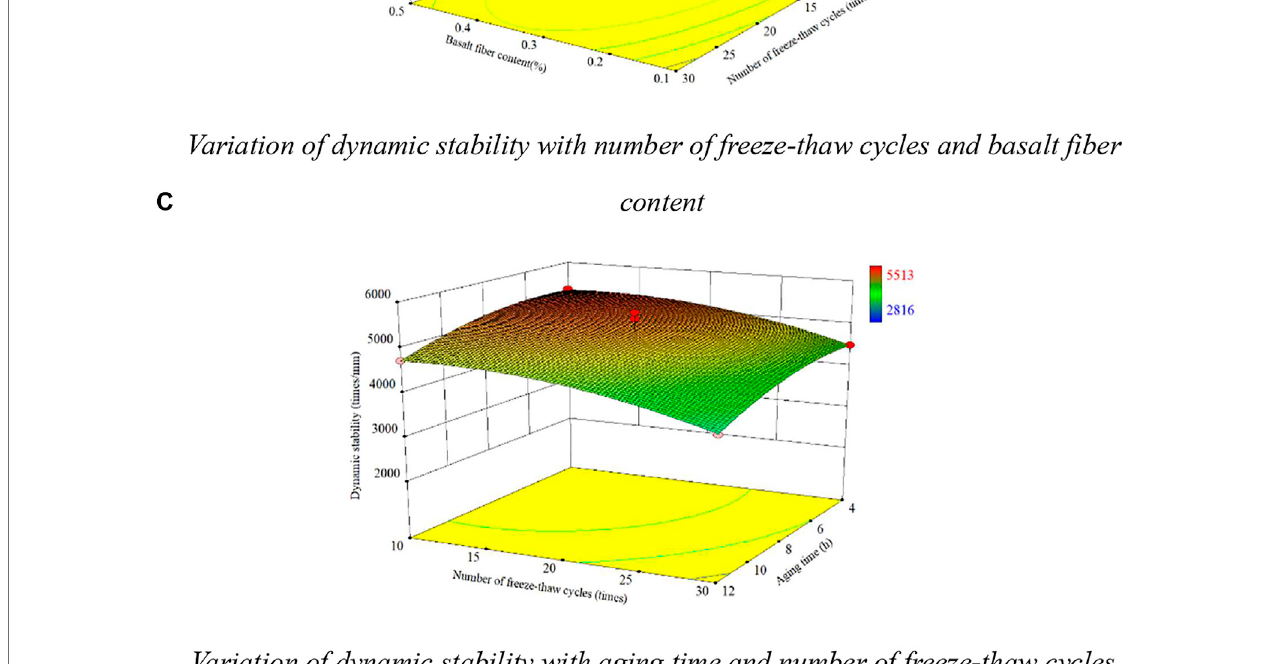
Frontiers in Materials |